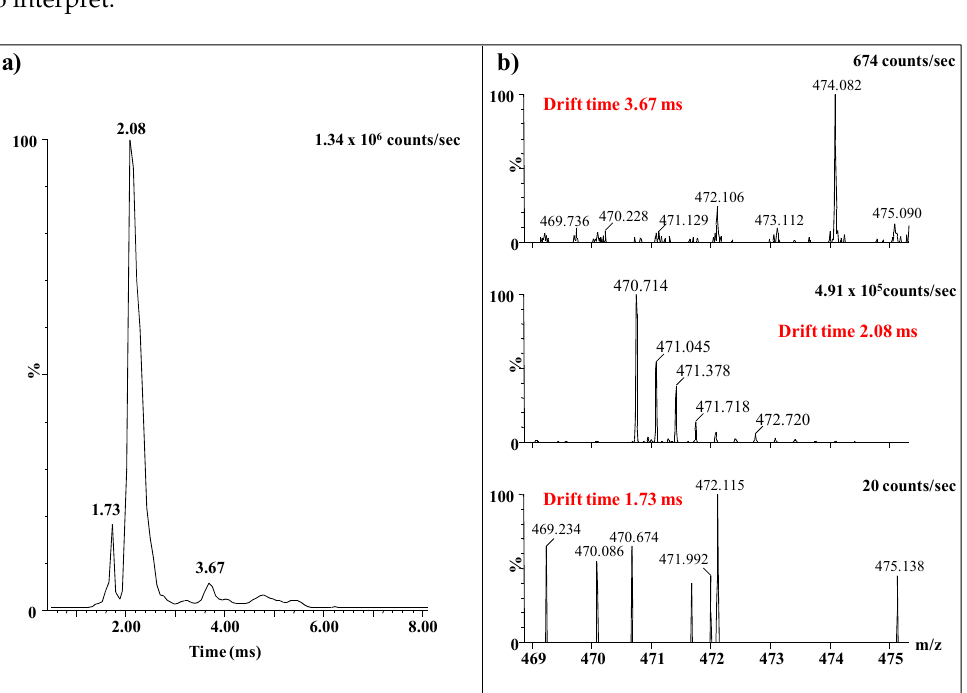
Figure 7. Negative ion mode nanoESI IMS CID MS/MS of the [M-4H+K] 3 − detected at m/z 470.714 in the MS depicted in Figure 4, corresponding to trisulfated 4,5- Δ -GlcAGalNAc[IdoAGalNAc] 2 . Collision energy 30 eV. For a better visualization of the fragment ions, the areas m/z 100 to m/z 350 and m/z 475 to m/z 1000 were magnified ×6 and ×10, respectively.